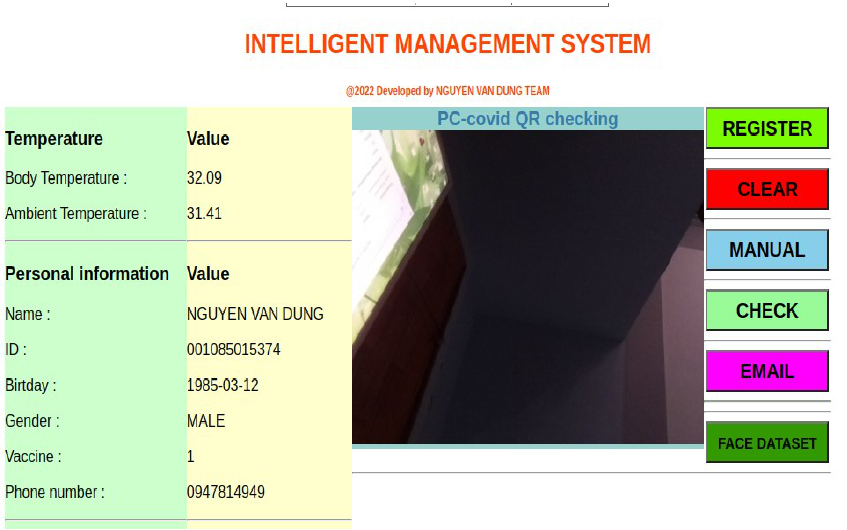
Figure 10. Display of the main page.